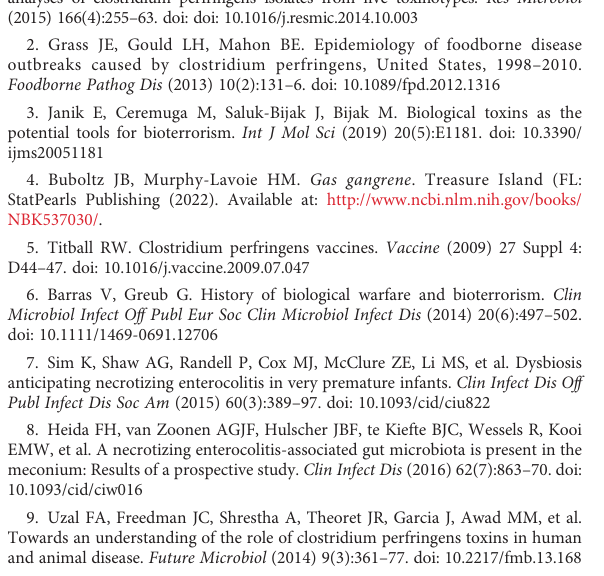
SUPPLEMENTARY FIGURE 1 DensityandpromiscuityoftheCTL-andHTL-epitopes. (A) Epitopedensityin proteins by epitope length (CTL-epitopes: 8, 9 and 10 aa, HTL-epitopes: 15 aa). (B) ThebarplotrepresentsintheX-axisthenumberofepitopesidenti fi ed, foreachepitopelength(Y-axis).ThecolorindicateshowmanyHLAsupertype alleles each epitope binds. In the bar plots (C) (for CTL-epitopes) and D (for HTL-epitopes), the Y-axis represents the number of epitopes that can bind a certain number of HLA supertype alleles (X-axis). Panels (E, F) show the distribution of the number and density, respectively, of HTL-epitopes in the proteins of each of the levels of evidence indicated in the X-axis. SUPPLEMENTARY FIGURE 2 Conservation of the nested candidate epitopes across C. perfringens toxinotypes. Each sub fi gure shows the alignment of the nested epitope, the epitope ID and the protein name. SUPPLEMENTARY FIGURE 3 (A) Mean pLDDT of the 22 multi-epitope (MEP) candidates. (B) Structural alignmentbetweenthecentroidofthemostpopulatedclusterofMEP_12, before (orange) and after (cyan) re fi nement. SUPPLEMENTARY FIGURE 4 Quality assessment of the centroid of the most populated cluster of MEP_12 before re fi nement. (A) Ramachandran plot for the general case.